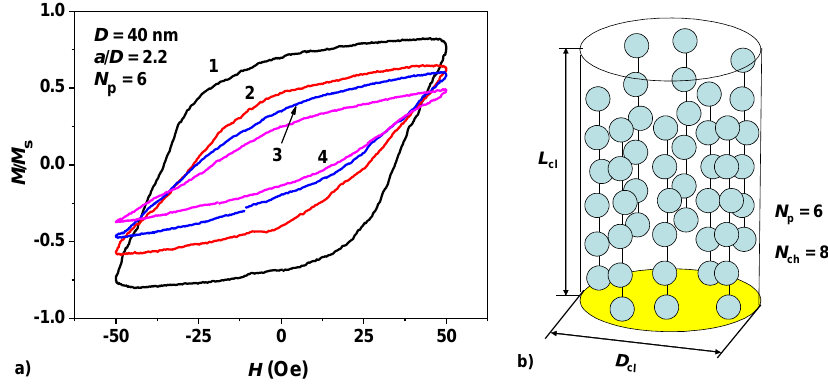
Figure 5. ( a ) Low-frequency hysteresis loops of dilute assemblies of cylindrical clusters of interacting chains of nanoparticles depending on the number of chains located inside the cluster: (1) N ch = 4, (2) N ch = 6, (3) N ch = 8, (4) N ch = 10. ( b ) The model of random oriented cluster of magnetosome chains used in the calculations.